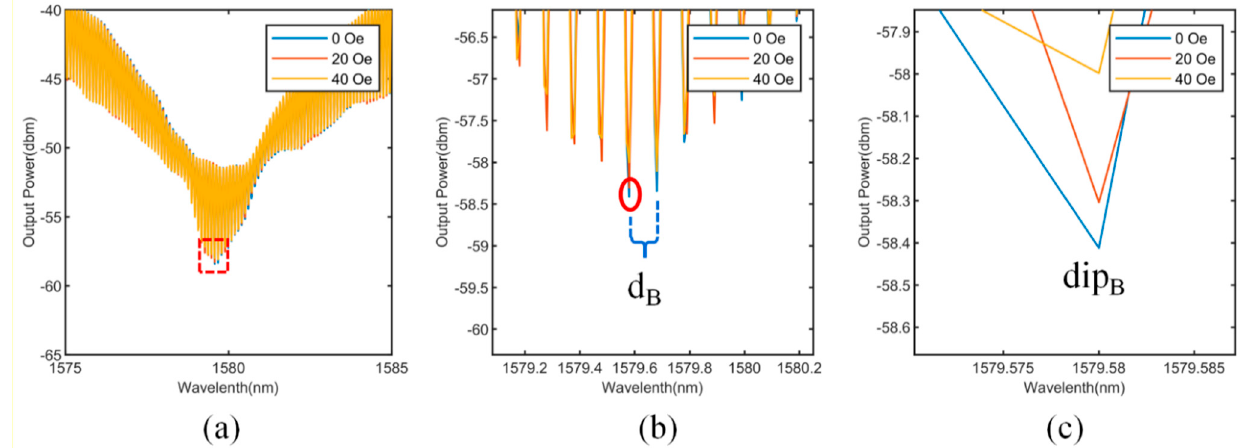
Figure 9. ( a ) The output spectrum of the sensor at different magnetic field strengths when the interference arm is placed in the Helmholtz coil. ( b ) Detailed diagram of interference fringe spacing d B . ( c ) Details of dip B .